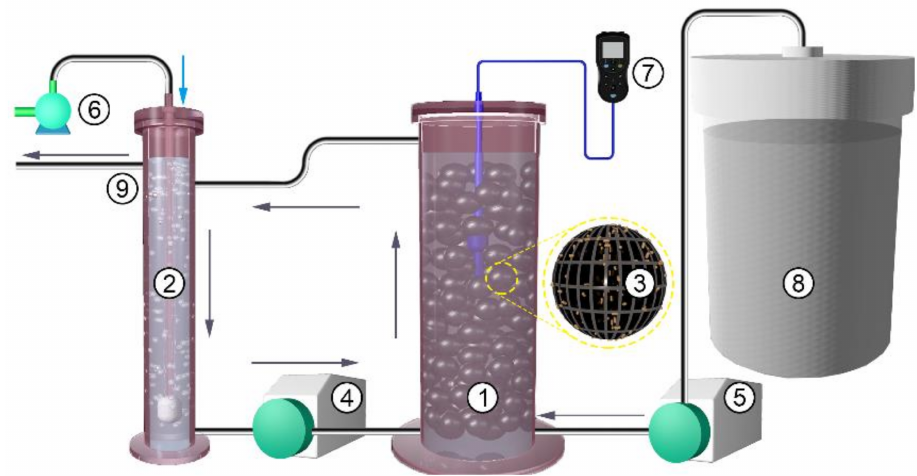
Figure 1. Schematic diagram of the simulated biofilm reactor (BR) system. 1 . The main reactor; 2 . the regulative reactor; 3 . the substrate (the biological balls); 4 . the peristaltic pump driving the internal circulation; 5 . the peristaltic pump controlling the influent rate; 6 . the air pump for aeration; 7 . the dissolved oxygen (DO) meter; 8 . the wastewater tank; 9 . the export of